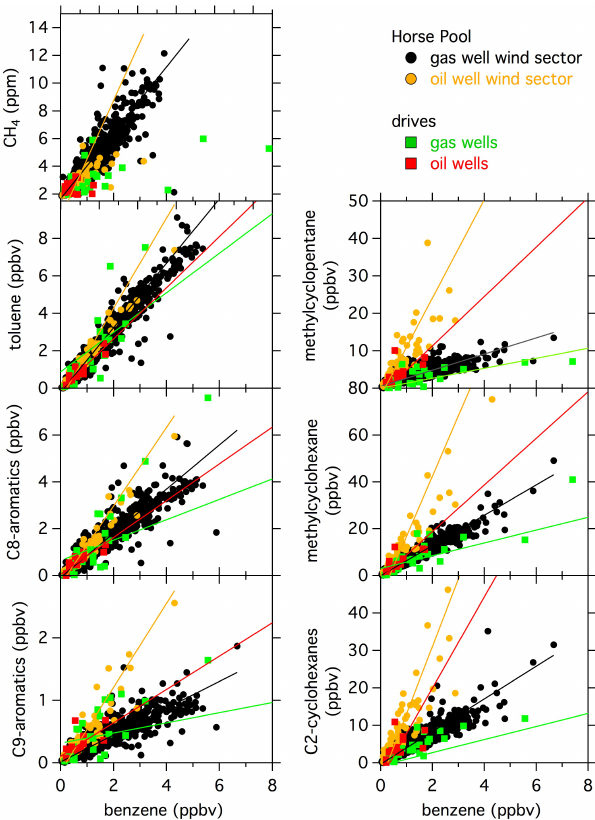
Figure 10. Scatter plots of various aromatics and cycloalkanes versus benzene for data from the Horse Pool ground site, separated into wind sectors that are dominated by either oil or gas wells, together with measurements from the mobile laboratory close to individual oil or gas well pads.